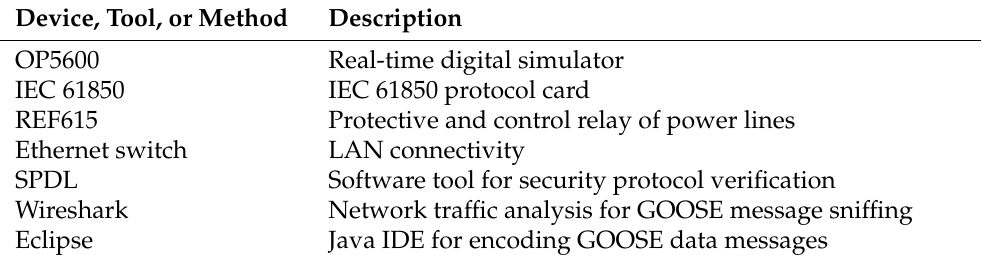
Figure 3. Practical setup of the proposed test system. Table 3. Devices, tools, and methods used in the